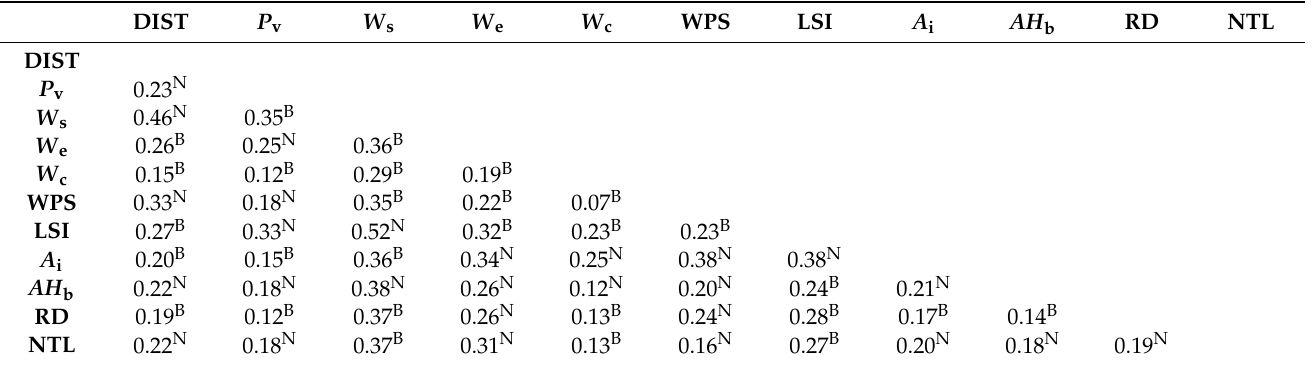
Table 6. Interaction analysis among potential influencing factors on WCR